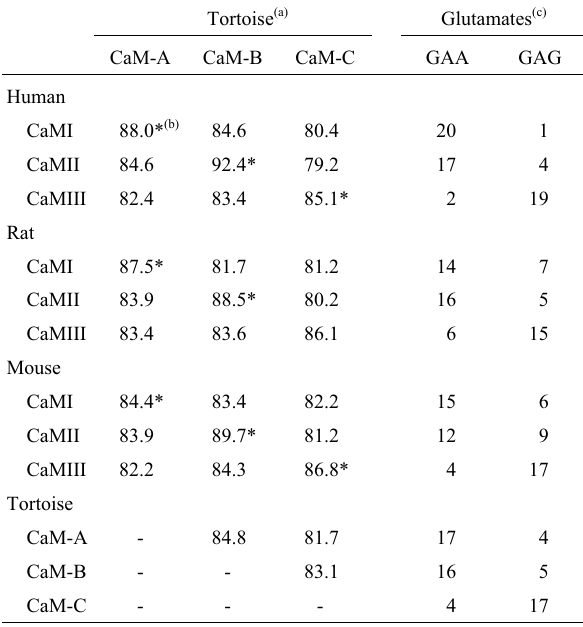
Table I - Homology of tortoise CaM genes with mammalian genes and their glutamate codon